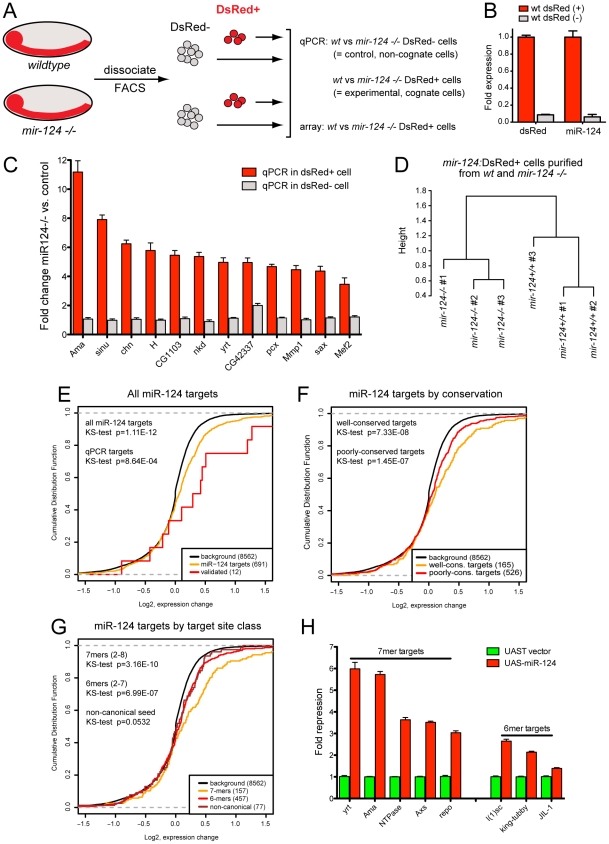
Gene expression in miR-124+ cells from wild-type and mir-124 mutants.(A) Scheme for isolation and analysis of cells. (B) qPCR validation that the sorted DsRed+ cells specifically express mir-124. (C) qPCR analysis of predicted miR-124 targets showed upregulation in miR-124:DsRed+ cells, but not miR-124:DsRed- cells. (D) Unsupervised hierarchical clustering of microarray data from miR-124:DsRed+ cells purified from wildtype and mir-124 mutant embryos collected 10–16 hrs after egg laying. (E–G) Cumulative distribution function (CDF) plots of various sets of predicted miR-124 targets in mutant vs. wildtype microarray data. Shifts to the right reflect overall upregulation of genes in the mir-124 mutant. (E) Global upregulation of all predicted miR-124 targets. (F) Transcripts with well-conserved miR-124 sites were upregulated more strongly than those with poorly-conserved target sites, although both sets were significantly upregulated. (G) Transcripts with 2–8 seed matches were upregulated more strongly than transcripts with 2–7 or non-canonical seed matches. (H) Sensor validation of direct repression of miR-124 targets by ectopic miR-124. Transcripts with 2–8 (7mer) targets generally repressed more strongly than those with 2–7 (6mer sites).